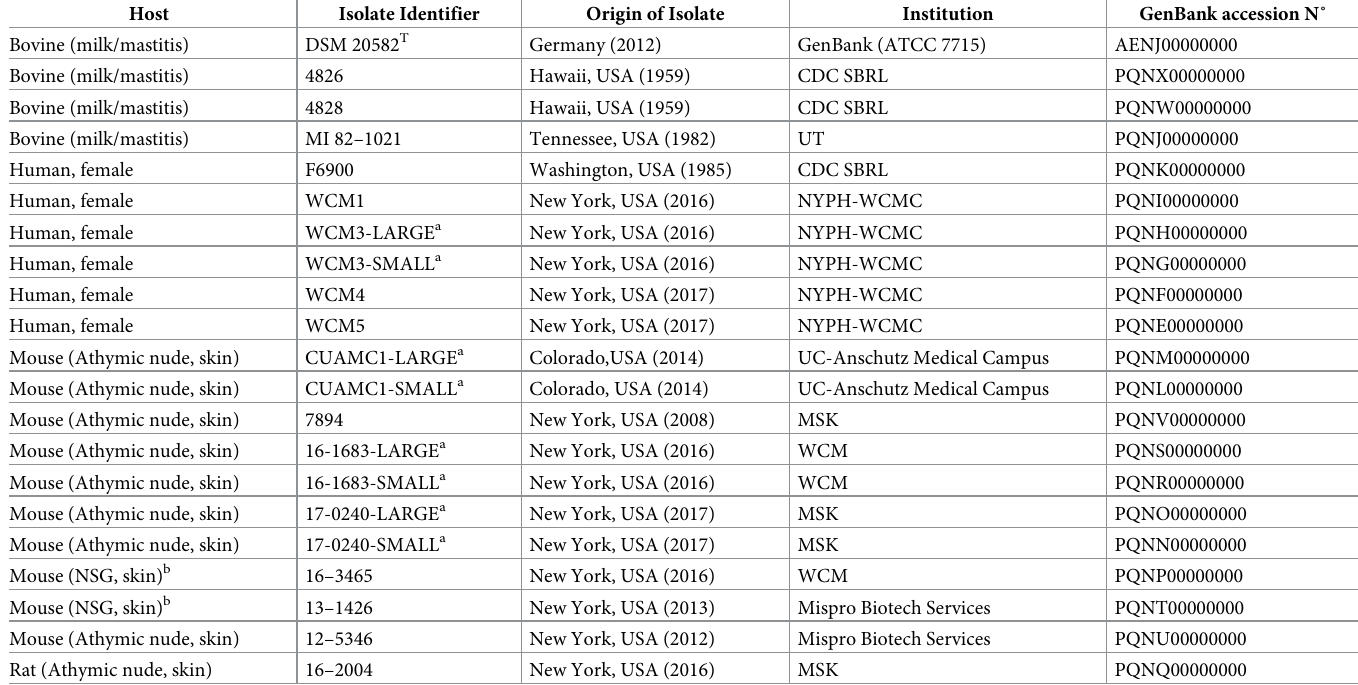
Table 1. Corynebacterium bovis isolates evaluated in this